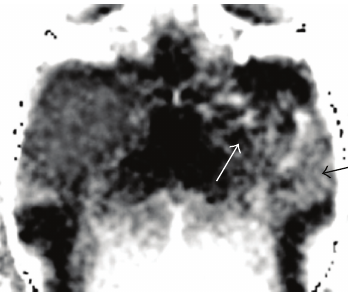
Figure 9: 0h R2 (cid:2) map shows that the signal of IP (black arrow) is higher than that of infarcted core (white arrow).